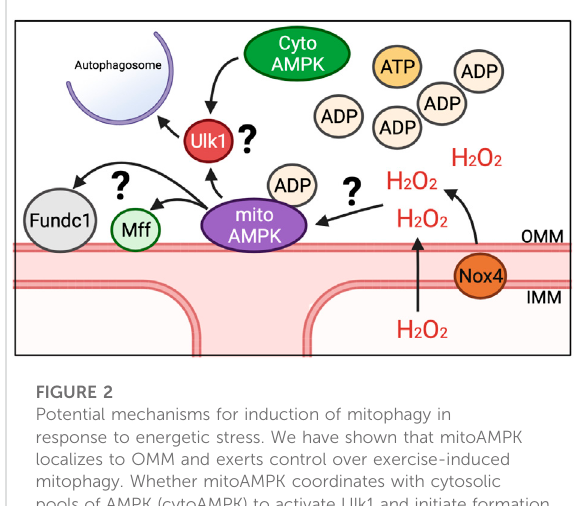
FIGURE 2 Potential mechanisms for induction of mitophagy in response to energetic stress. We have shown that mitoAMPK localizes to OMM and exerts control over exercise-induced mitophagy. Whether mitoAMPK coordinates with cytosolic pools of AMPK (cytoAMPK) to activate Ulk1 and initiate formation of autophagosomes is unknown. Additionally, it is unclear what roles other mitophagy-related proteins localized to mitochondria (e.g., Fundc1 and Mff) play in mitoAMPK regulation of mitochondrial quality control or the role of mitochondrial- generated ROS, potentially through